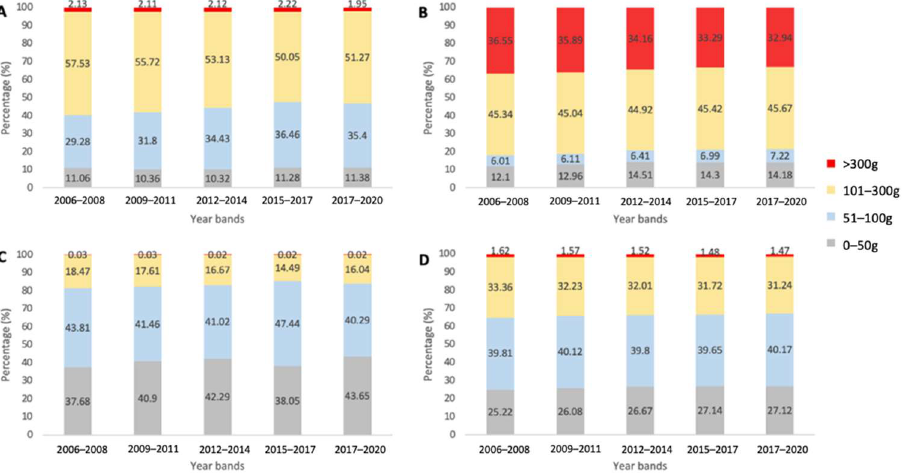
Figure 1 . Proportion of total sales per capita of savoury snacks over three-year periods from 2006 to 2020 according to package size bands in ( A ) Australia, ( B ) the USA, ( C ) Japan, and ( D ) Hong Kong .